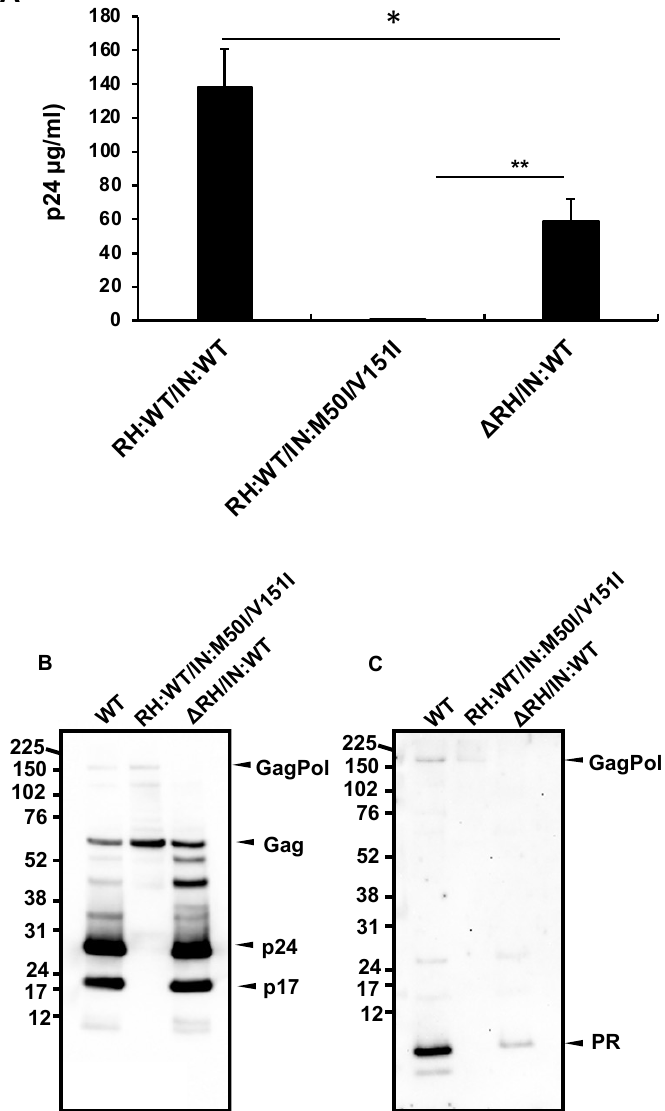
Figure 3. The C-terminal domain of RH regulates virus release and autoprocessing in HIV(IN:WT). ( A – C ) Each construct was transfected into HEK293T cells. Transfection supernatants were collected, and viral particles in the supernatants were pelleted as described in the Materials and Methods (Section 2.4). Each viral pellet was resuspended in 1/100 of the transfection supernatants in complete culture media or PBS. ( A ) P24 concentration in the suspension was determined by measuring HIV p24 antigen by ELISA. Data indicate means ± SEs (n = 5); statistical analysis was conducted using one-way ANOVA (Prism). ( B , C ) Virus particles are isolated as described in the Materials and Methods (Section 2.4). 1 μ g of viral lysates was subjected to WB. Gag/GagPol-cleaved products and PR were detected by rabbit polyclonal anti-p17/p24/Gag ( B ) and anti-PR antibodies ( C ). *: p < 0.05, **: p < 0.01.